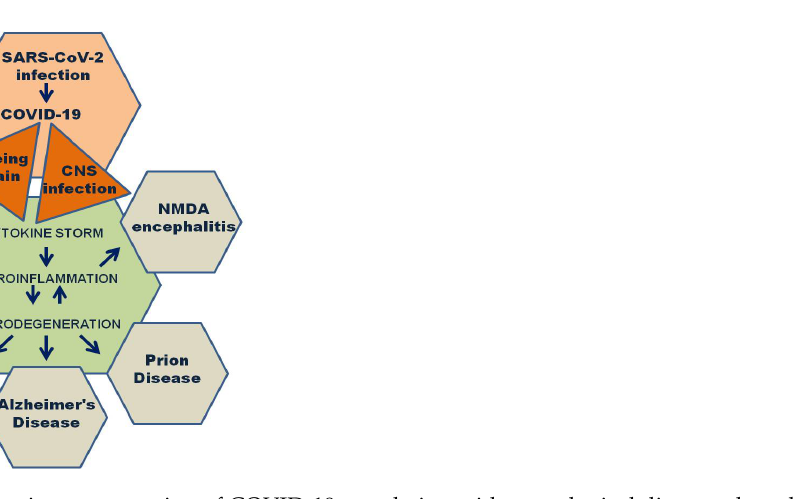
Figure 1. Schematic representation of COVID-19 correlation with neurological diseases, based on study findings.